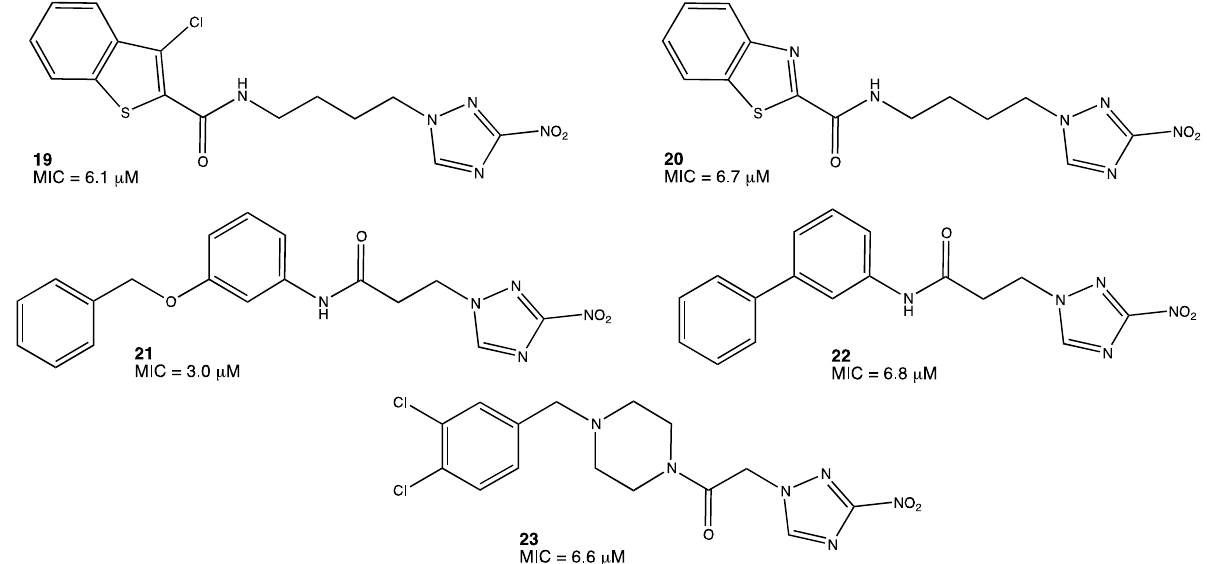
Figure 9. Nitrotriazole derivatives with antitubercular activity [34].